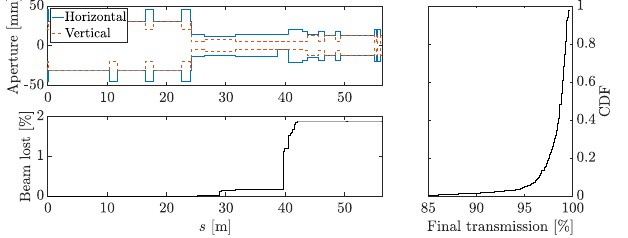
FIG. 10. Transmission results for the BTA transfer line includ- ing the BTS and the first sector of the AR after trajectory correction. The left plots show the aperture model (top) and the mean cumulative beam loss along the BTA (bottom). The right plot shows the cumulative distribution function (CDF) of the final beam transmission. Beam losses occur mainly at the septum location at around 40 m.